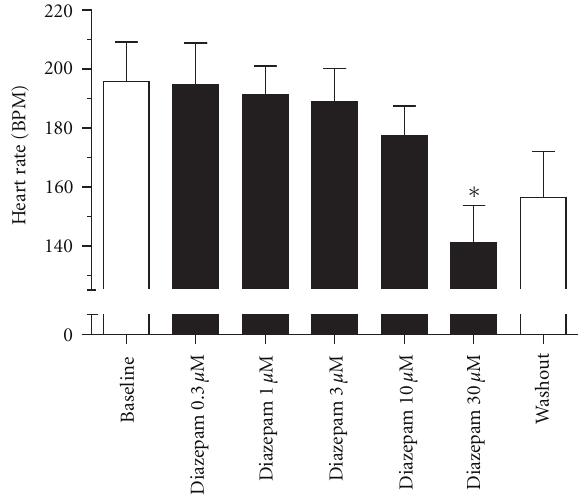
Figure 4: E ff ect of diazepam on isolated retrograde perfused female guinea pig hearts (868 ± 45g). After a minimum of 30 min stabilization, the hearts underwent 20min of baseline